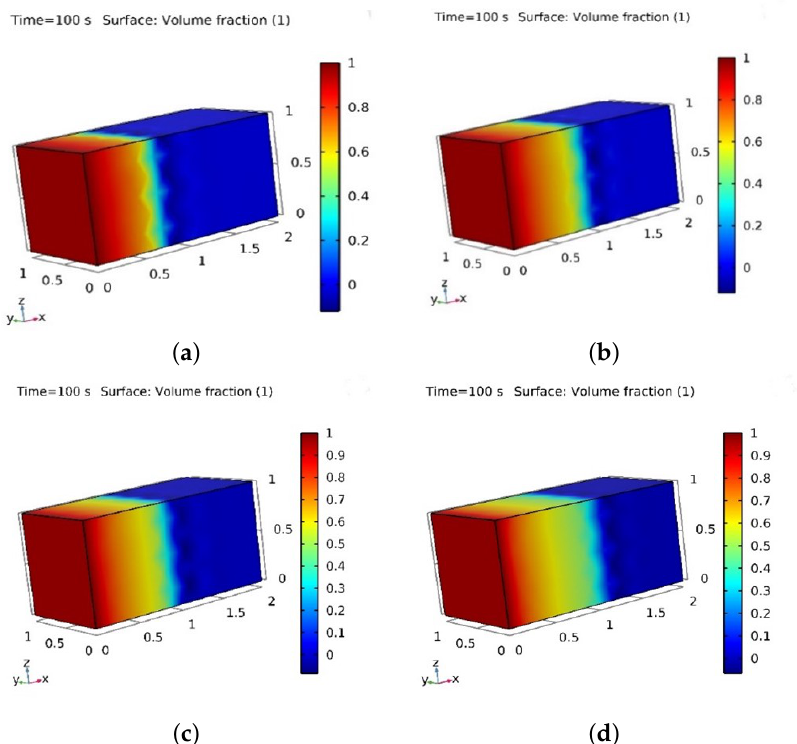
Figure 10. ( a ) Water saturation at 100 s, ( b ) copper at 100 s, ( c ) aluminum at 100 s, and ( d ) silicon oxide at 100 s.